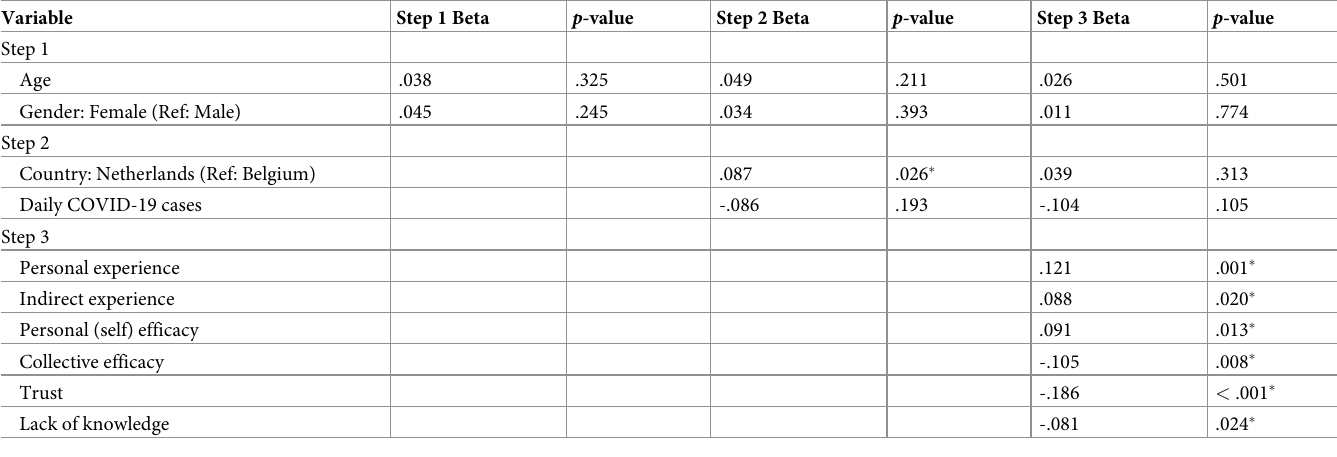
Table 2. Hierarchical multiple regression predicting perceived